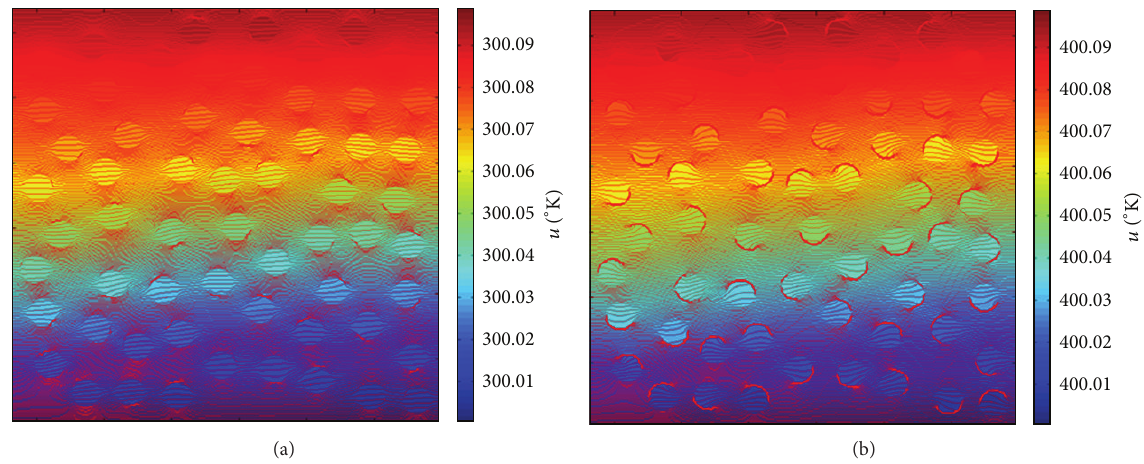
Figure 7: Contour of temperature in the heterogeneous media at different state of applied temperature.